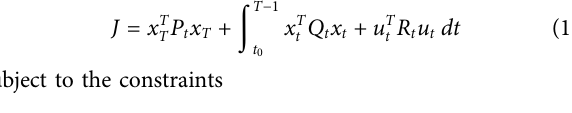
FIGURE 5 | Conditioned trajectory distribution for joint one.